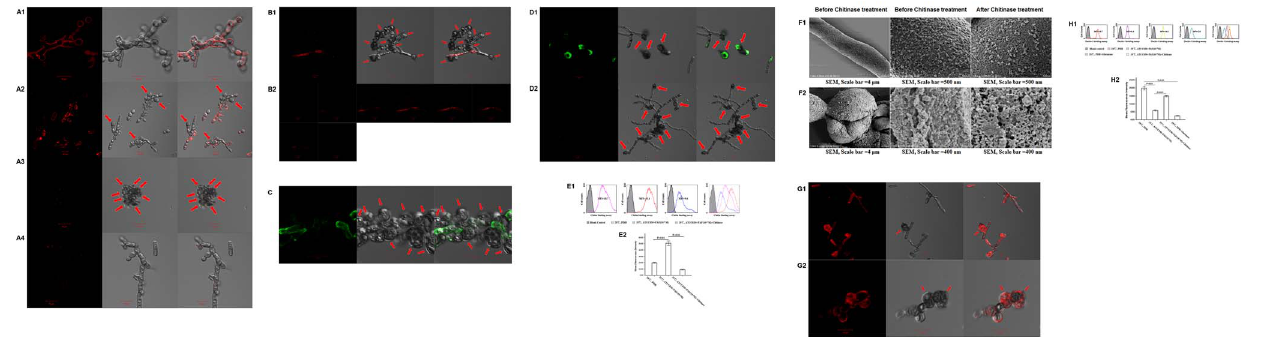
Fig. 5. A chitin-like component masks the immunorecognition of b -glucans on sclerotic cells by Dectin-1. (A1–A4) The binding of murine-derived Dectin-1 to the saprophytic F. pedrosoi in PDB before (A1) and after (A4) b -glucanase treatment, or to the 30-day (A2) and 50-day (A3) induced cultures containing sclerotic cells in ATCC medium 830 was detected by PE-anti-murine Dectin-1 mAb using confocal microscope. (B1 and B2) The binding of human-derived Dectin-1 to the induced cultures containing sclerotic cells was detected by PE-anti-human Dectin-1 mAb using confocal microscope. (C) The binding of murine-derived mannose receptor (MR) to the induced cultures containing sclerotic cells and chlamydospores was detected by FITC-anti-murine MR using confocal microscope. (D) FITC-WGA was used to detect the distribution of chitin-like component on the induced cultures containing sclerotic cells before (D1) and after (D2) Chitinase treatment using confocal microscope. (E1 and E2) The binding capacity of FITC-WGA to the saprophytic F. pedrosoi or to the induced cultures before and after chitinase treatment was detected using flow cytometry assay, and represented as the Mean Fluorescence Intensity (MFI). The induced cultures without any treatment were set as blank control. (F1 and F2) SEM was used to observe the surface ultra-structure of saprophytic hypha (F1) and in vitro-transformed sclerotic cells (F2) in the presence or absence of chitinase pretreatment. SEM, Scale bar 5 4 m m (left) or 500 nm (middle and right). (G1 and G2) The binding of murine-derived Dectin-1 to the induced cultures containing sclerotic cells with chitinase pretreatment was detected by confocal microscope. (A-D, G) The transformed sclerotic cells and chlamydospores were indicated by red arrows. (H1 and H2) The binding capacity of murine-derived Dectin-1 to the saprophytic F. pedrosoi before and after b -glucanase treatment, or to the induced cultures before and after chitinase treatment was detected by indirect immunofluorescence assay using flow cytometer, and represented as the Mean Fluorescence Intensity (MFI). The fungal cells only incubated with PE-conjugated anti-murine Dectin-1 mAb were set as blank control. (E2 and H2) Data are shown as mean ¡ SEM from three individual experiments performed in triplicates, and significance tested using LSD-t